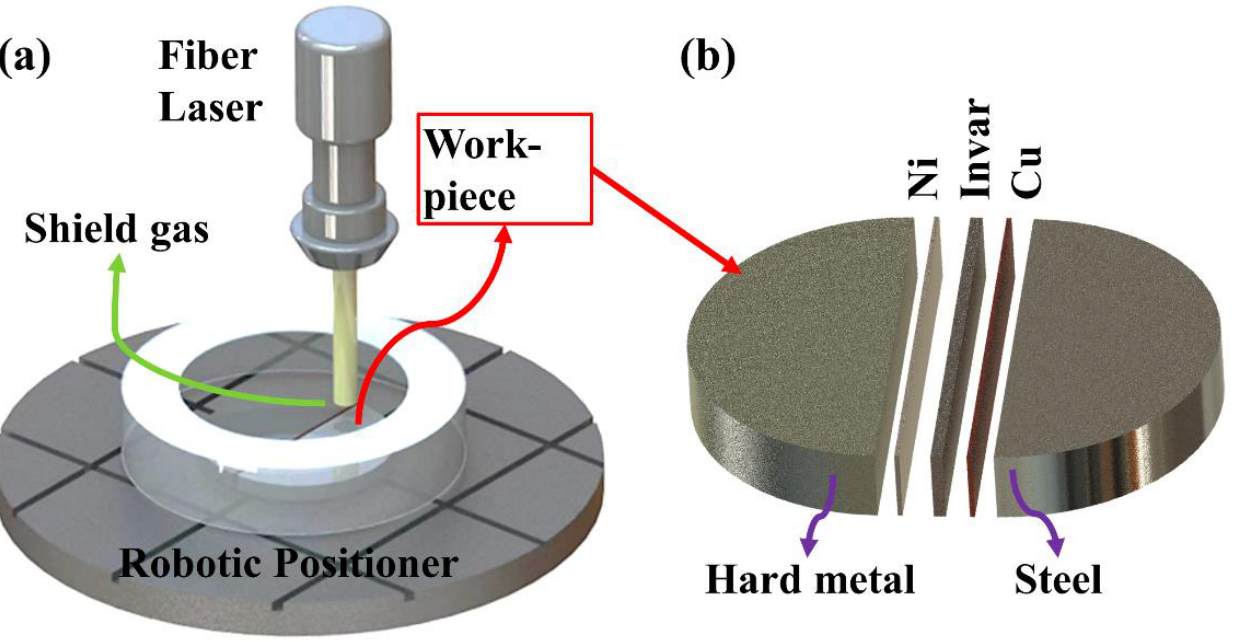
Figure 1. ( a ) Experimental setup for laser welding-brazing robotic system. ( b ) Preplaced brazing filler metals between cemented carbide and steels. Table 1. Laser welding-brazing parameters of cemented carbides and